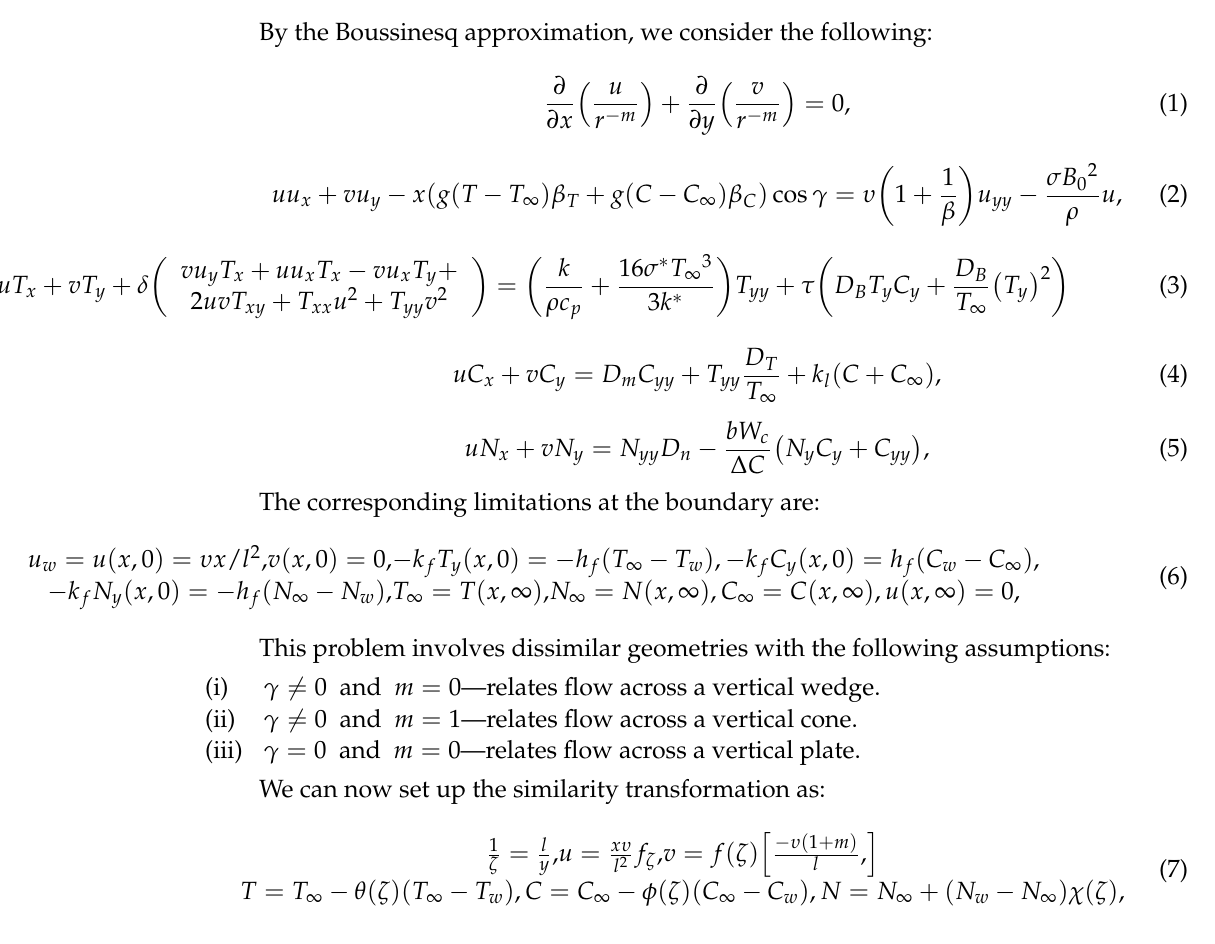
Figure 1. Physical representation.